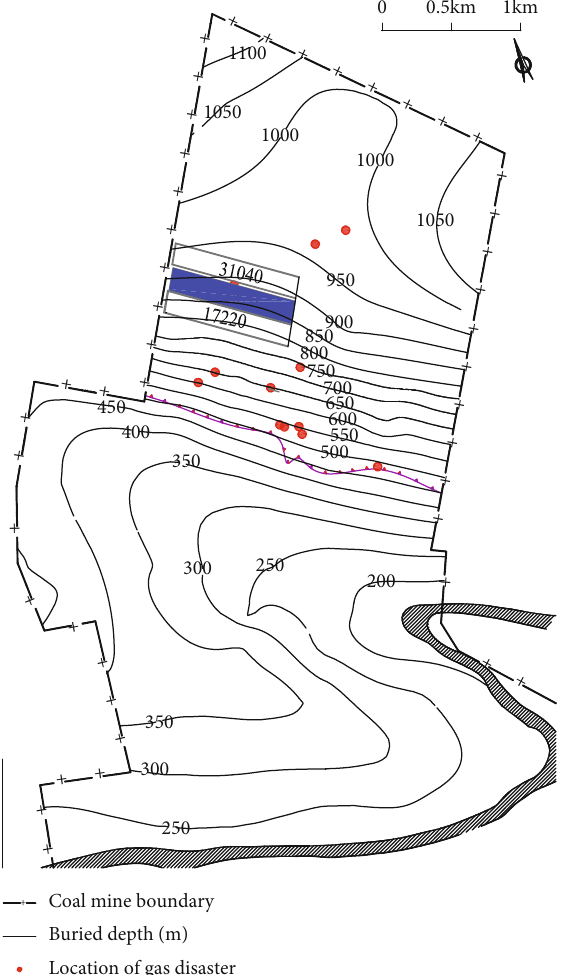
Figure 2: Schematic diagram of panel 31020.